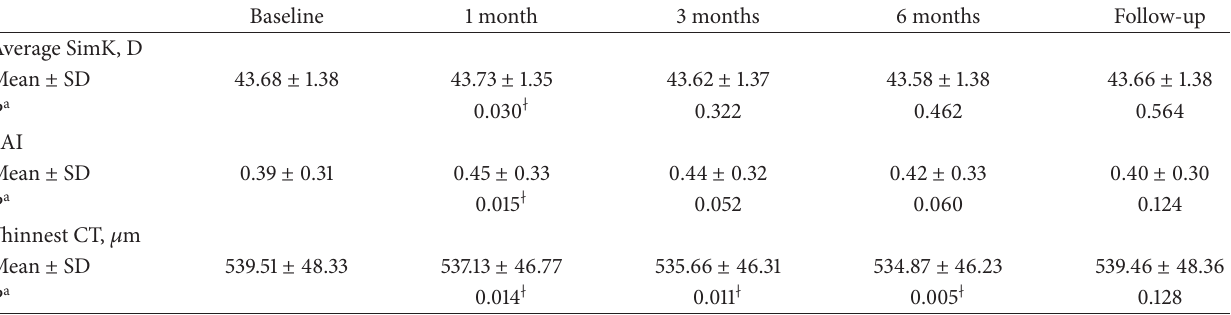
Table 2: Corneal topographical parameters measured with Sirius before and after treatment.